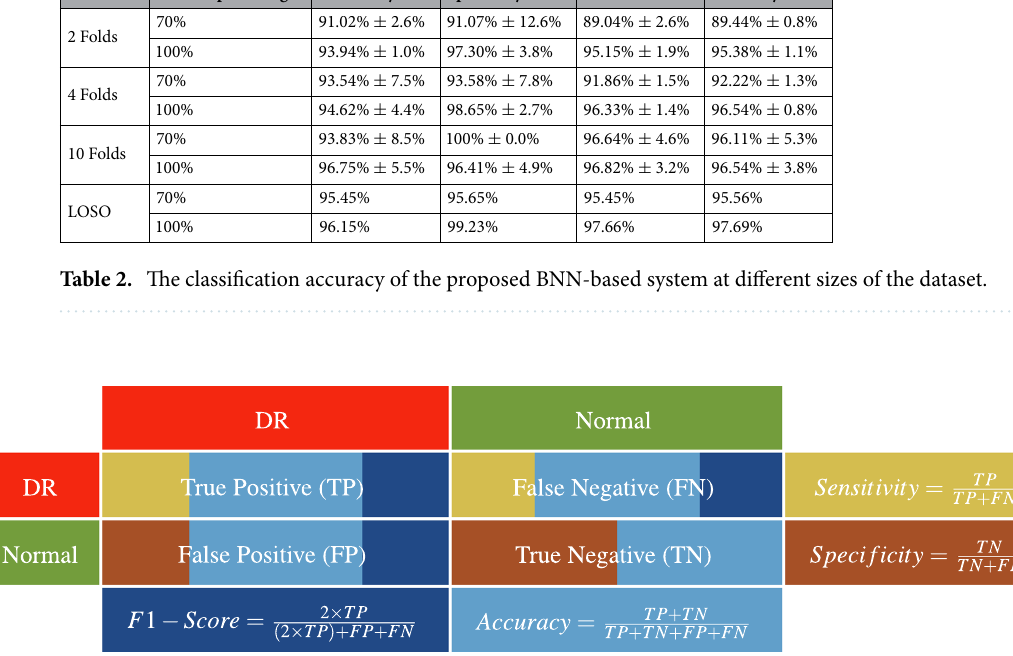
Table 3. Performance metrics used for the diagnostic evaluation of the proposed system. TP ( TN ) is the number of times identifying the DR (normal) classes correctly, while FN ( FP ) is the number of times identifying the DR (normal) classes